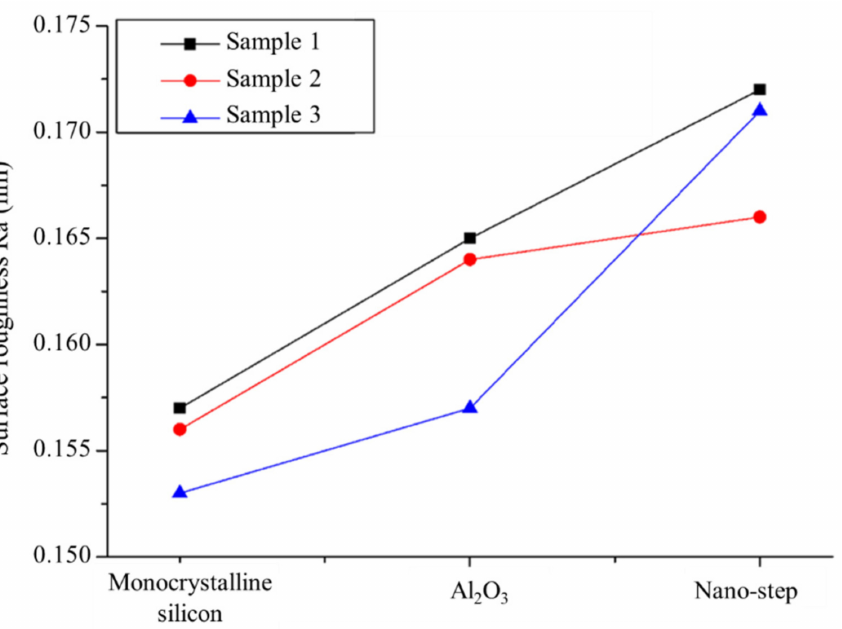
Figure 5. Comparison of surface roughness among monocrystalline silicon, Al 2 O 3 film, and